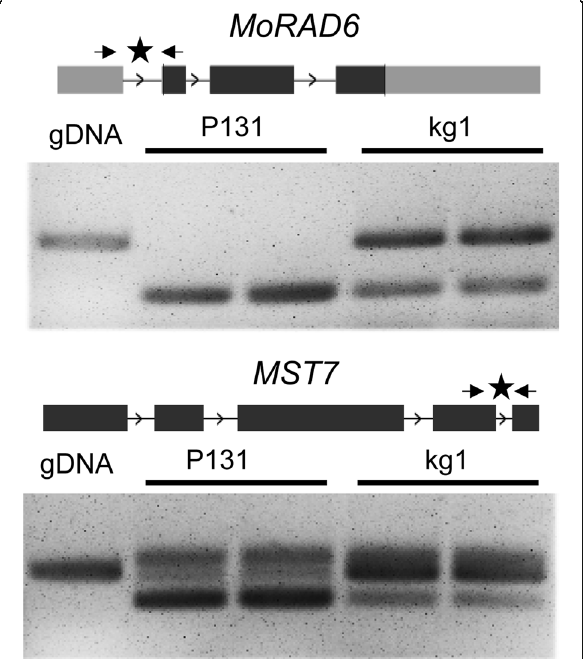
Fig. 6 MoGrp1 is necessary for normal splicing of genes involved in infection-related morphogenesis. RT-PCR analysis on selected introns (marked with a star) of MoRAD6 and MST7 , which were abnormally spliced in the Δ Mogrp1 mutant kg1 in comparison with the wild- type strain P131. The amplified genomic DNA was used as the un- spliced control. The transcripts are presented with exons in black rectangles, UTRs in grey rectangles, and introns indicated by black lines. The PCR primers are marked with